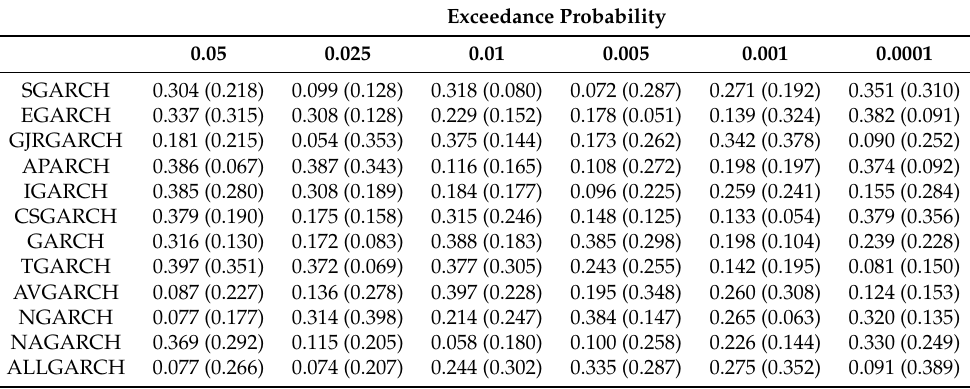
Table 6. p -values of the unconditional (conditional) coverage value at risk exceedance test for the log returns of the exchange rates of Maidsafecoin from 22 June 2014–17 May